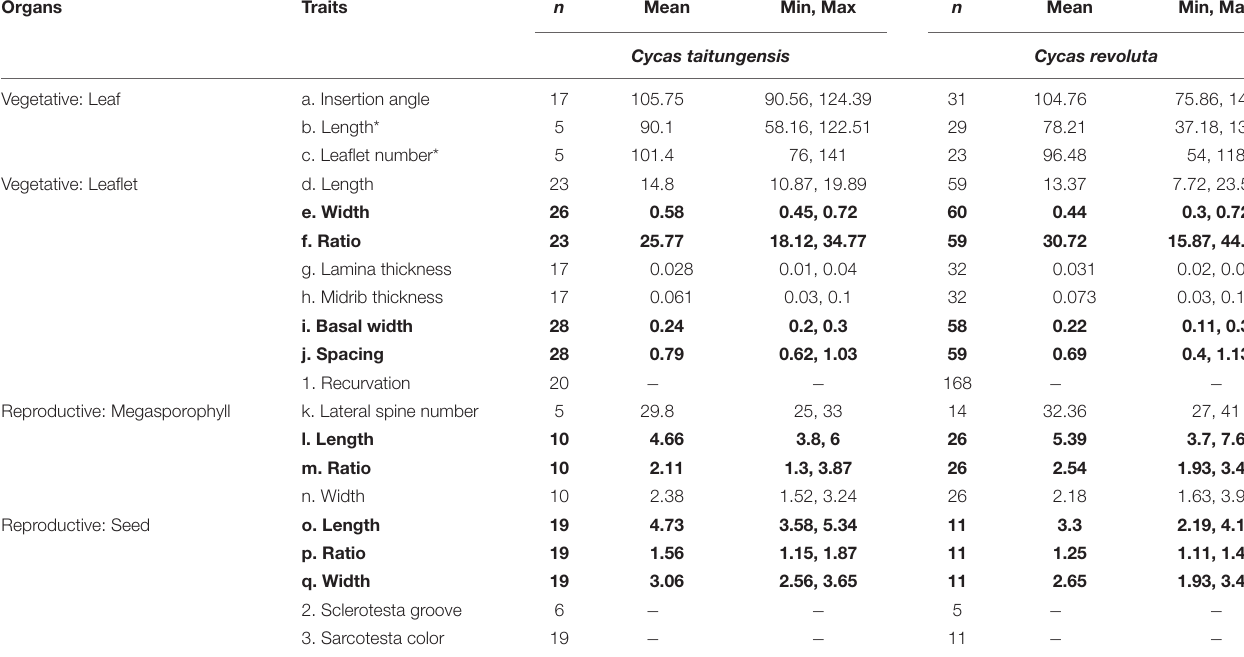
TABLE 2 | Measurement of vegetative and reproductive traits in two species. Organs